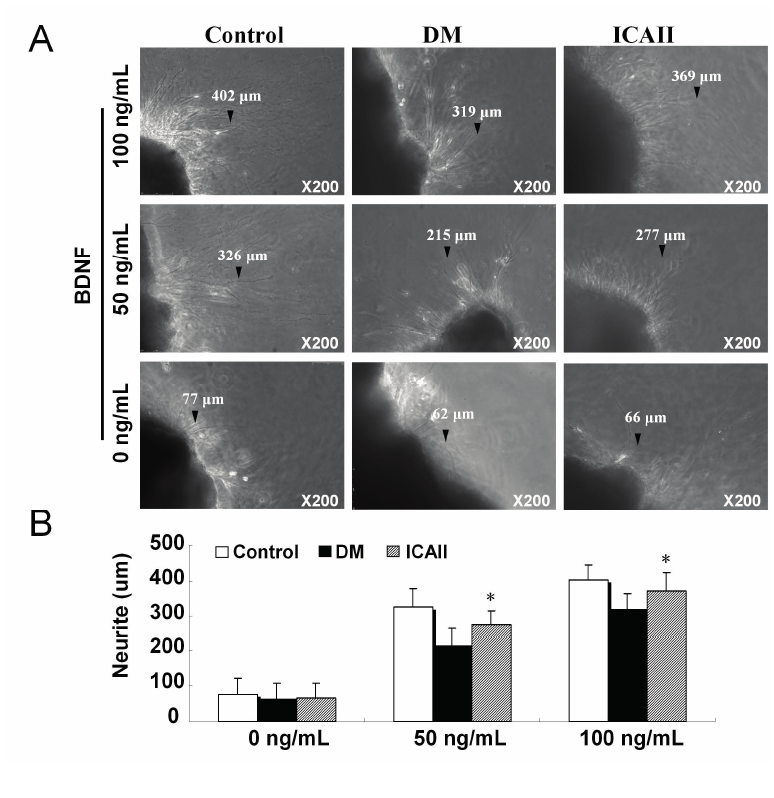
Figure 6. Neurite lengths of major pelvic ganglia treated with brain-derived neurotrophic factor (BDNF) cultured for 48 h in normal control and diabetic rat groups (the black arrows showed the typical neurite). ( A ) Representative photographs of major pelvic ganglia neurite with 0/50/100 ng/mL BDNF; ( B ) Average neurite length of major pelvic ganglia analysis results. Each bar depicts the mean values (±standard deviation) from N = 10 animals per group. * p < 0.01 in the ICA II-treated group compared with DM placebo